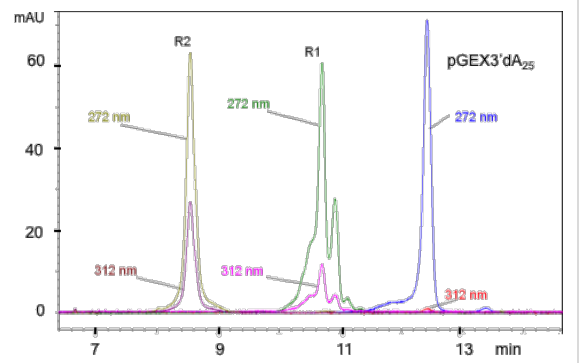
Figure 3: Capillary electrophoresis (CE) overlapping traces of oligo- deoxynucleotides pGEX3’-dA 25 intact and pGEX3’-dA 25 at R1 and R2 levels of osmylation per protocols A and B, respectively (Experimental section, Part A). Materials are at comparable, but not identical, con- centrations. Migration is in the order of intact oligo last, R2 early, and R1 in the middle. Traces are shown at two wavelengths, at 272 and 312 nm, to illustrate that DNA exhibits about 1% absorbance, whereas R1 and R2 absorb substantially, and R2 > R1. The detail in the R1 peak is attributed to different topoisomers produced from either top or bottom addition to the C5–C6 double bond. Topoisomers exist also with R2, but are too many to be resolved. The ratio R(312 nm/272 nm) represents a normalization, and the wavelengths are selected to maxi- mize the value of R [46].